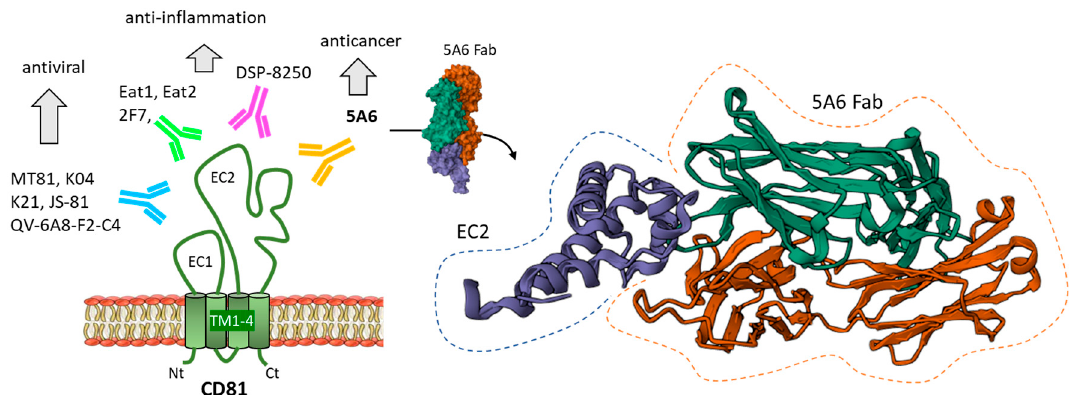
Figure 4. Different anti-CD81 antibodies (mAbs) have been discovered. They are used to study CD81 expression and/or function, notably to characterize membrane-bound CD81 on exosomes. Several anti-CD81 mAbs, such as QV-6A8-F2-C4, MT81, K04, K21 and JS-81 can be used to control virus entry into cells. The mAbs 2F7, Eat1 and Eat2 have been essentially used to study autoimmune encephalomyelitis and colitis, whereas mAb DSP-8250 has been tested against IBD. The lead mAb 5A6 displays marked antitumor activities, in murine models of B cell lymphoma and triple-negative breast cancer. A molecular model of the Fab fragment of 5A6 bound to CD81-EC2 is shown (PDB: 6U9S). 5A6 recognizes a conformational epitope on CD81 that is masked when CD81 is bound to CD19 [79].